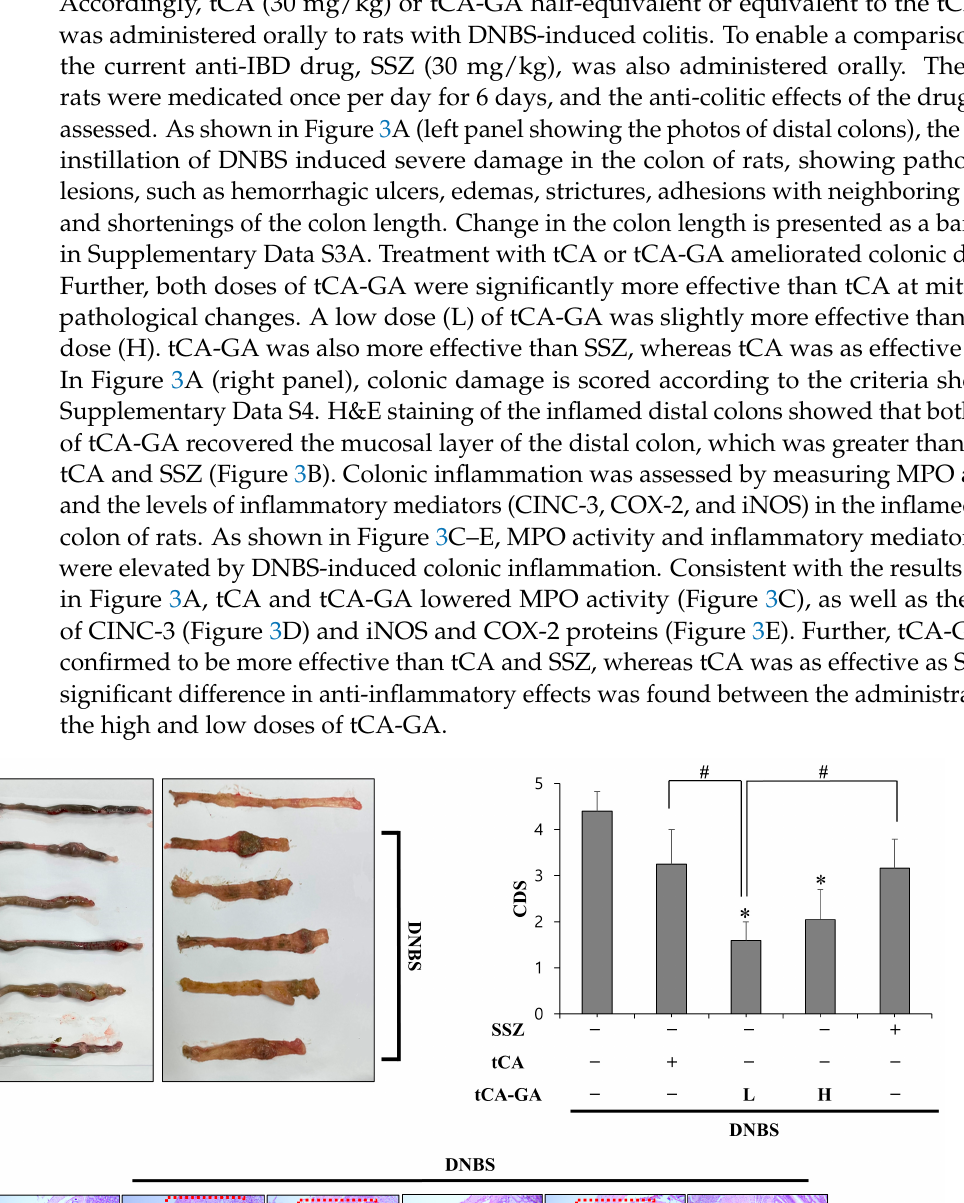
Figure 3. tCA-GA potentiates the anti-colitic activity of tCA and is more effective than SSZ at ameliorating rat colitis. DNBS-mediated colitis was induced for 3 days, and tCA (30 mg/kg), SSZ (30 mg/kg) or tCA-GA [equivalent to 15 mg/kg (L), as well as 30 mg/kg (H) of tCA] suspended in PBS (1.0 mL) was administered orally to colitic rats once per day. One day after the last treatment, the rats were killed to evaluate anti-colitic effects of the drugs. ( A ) Left panel: Photos of the distal colons of rats where serosal and luminal sides are shown separately. Right panel: Overall colonic damage was scored for each group and presented as colonic damage score (CDS). * α < 0.05, vs. DNBS control ( B ) H&E staining was performed with the colon sections of rats subjected to various treatments. Upper panel: Representative images of 100× magnification (scale bar: 200 µm). Lower panel: Representative images of 200× magnification for the dotted boxes in the upper panel (scale bar: 100 µm). In the inflamed distal colons (4.0 cm), ( C ) myeloperoxidase (MPO) activity was measured in addition to determining the levels of ( D ) CINC-3, ( E ) iNOS, and COX-2 using an Elisa kit and Western blotting. A loading control ( α -tubulin) was used for Western blot analysis of COX-2 and iNOS. The data in ( A , C , D ) are presented as mean ± SD (n = 5). Statistical significance was analyzed using a one-way ANOVA followed by Tukey’s HSD test, * p < 0.05, vs. DNBS control. # p < 0.05.